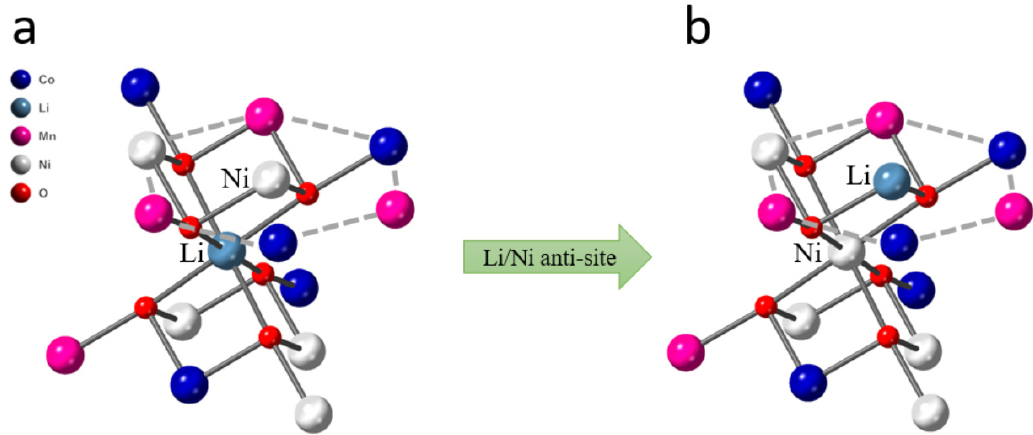
Figure 5. The local coordination structure of Li/Ni anti-site. ( a ) Before Li/Ni anti-site, ( b ) after Li/Ni anti-site. Purple represents Mn, white represents Ni, dark blue represents Co, light blue represents Li, and red represents O.